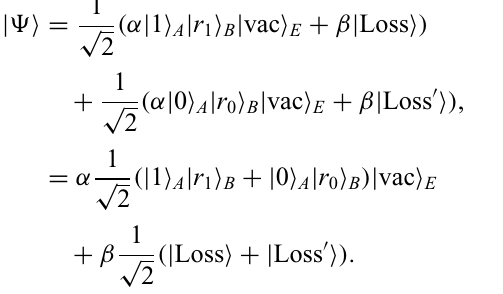
FIG. 3. Atomic level scheme for the communication